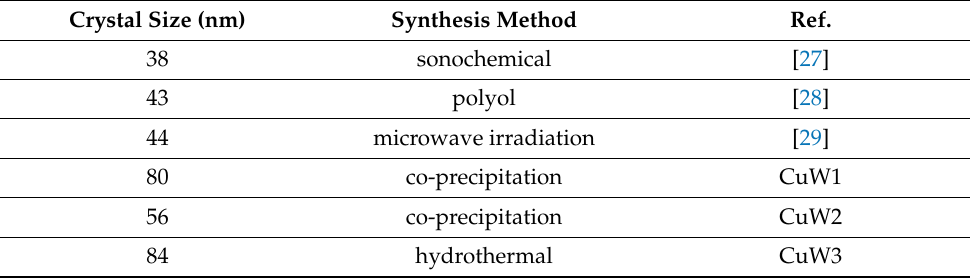
Table 1. Comparative study of CuWO 4 crystallite size depending on the method of synthesis used.